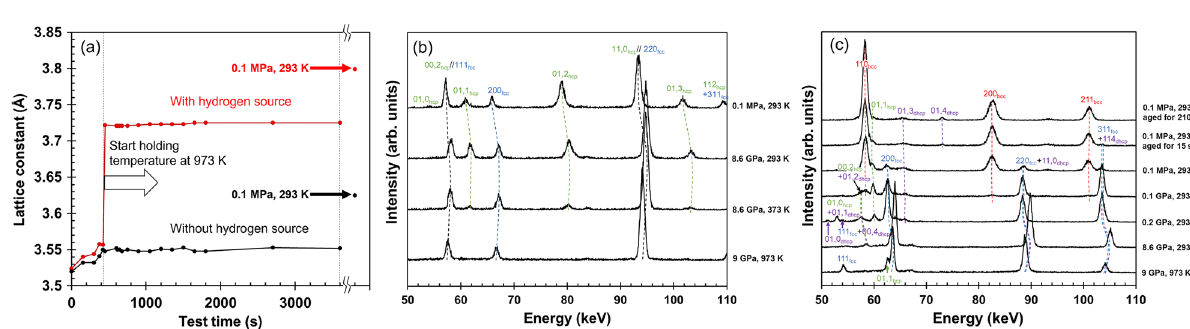
Figure 4. ( a ) Variations of fcc lattice constants obtained by the in situ diffraction experiments and the corresponding profiles taken in the ( b ) non-hydrogenated and ( c ) hydrogenated